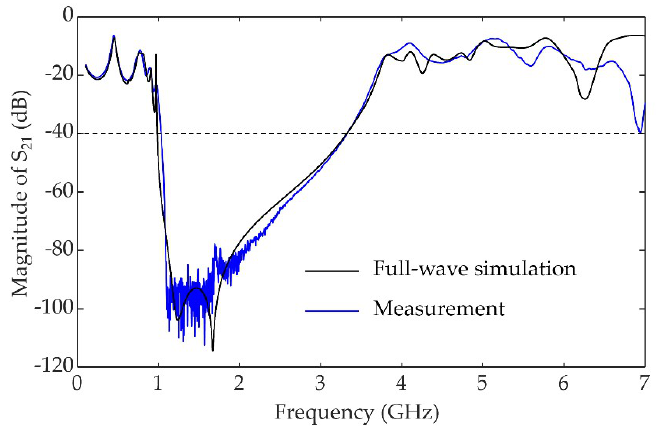
Figure 12. Measured and simulated S 21 parameters of the DP–EBG structure.